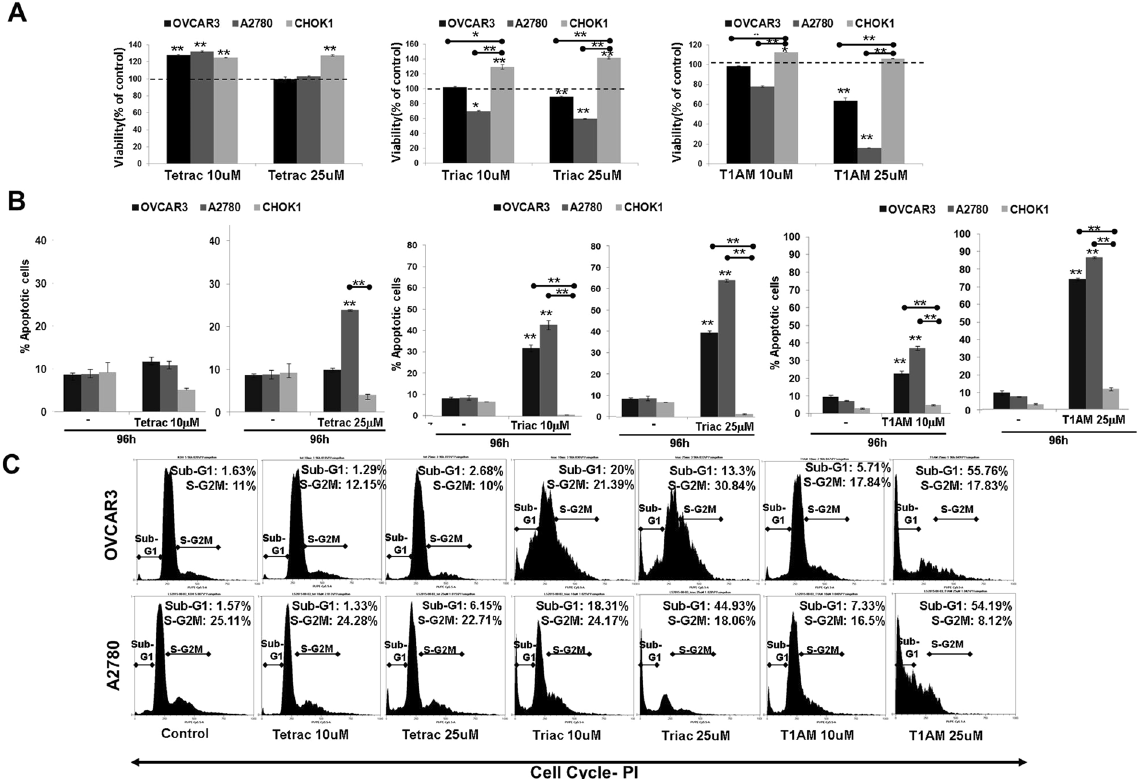
Figure 3. Tetrac, triac and T1AM induce apoptosis. Cells were treated with the analogs (10 or 25 μ M) for 96 hours and assessed by ( A ) Cell viability (PrestoBlue) ( B ) annexin-FITC/PI and ( C ) Cell cycle distribution. Experiments were repeated 3 times in triplicates. Significance ( * p < 0.05, ** p < 0.005) from vehicle control (KOH) or from normal control cells (indicated by ) is